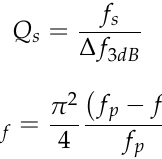
The frequency response of the IDT-Floating resonator with the 12- µ m-width reflec- tion boundary was also measured, as shown in Figure 8a. The measured results show its f s = 401.2 MHz, f p = 402.8 MHz, and Q s = 4457.8 are similar as the IDT-Ground resonator with d = 12 µ m, and its k 2 eff increases from 0.6% to 0.94% due to smaller static-capacitance value. However, its Q p value significantly drops from 839.5 to 324.8. To further ana- lyze the cause of the Q p decrease in the IDT-Floating structure, the MBVD model was constructed to fit the measured admittance curves and extract the equivalent circuit parameters, as shown in Figure 8b. The equivalent circuit is composed of a mechanical resonance branch, which includes a motional inductance ( L m ), a motional capacitor ( C m ), and a motional resistance ( R m ) in series, corresponding to the mass, stiffness, and damping of the mechanical system,